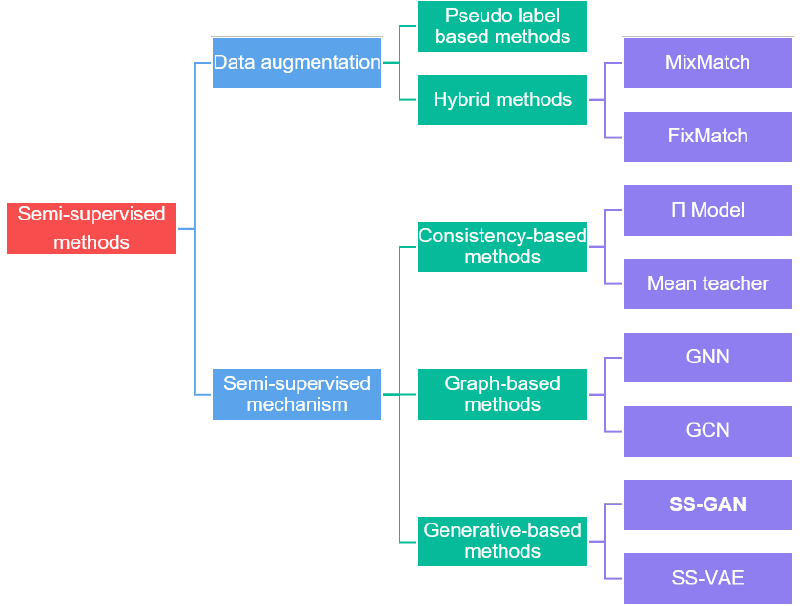
Figure 12. Overview of semi-supervised methods.